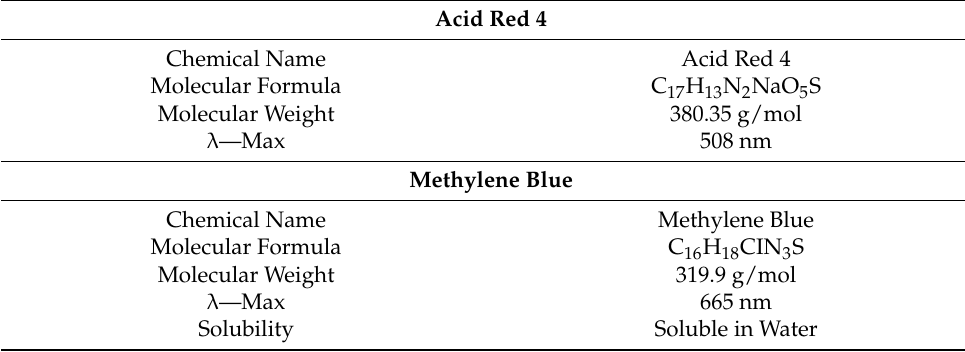
Table 1. Physiochemical properties of Acid Red 4 and Methylene